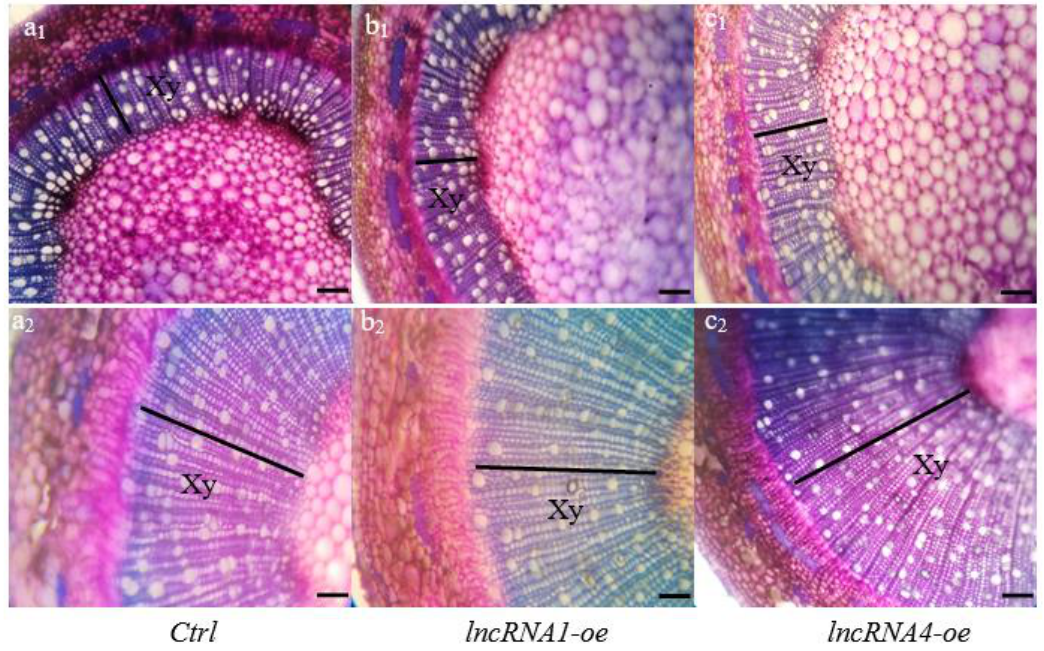
Figure 9. The slice of overexpression and wild type 84K poplar trees. ( a1 ) represented the central stem, ( a2 ) was the basal part of ten-week-old wild type 84K. ( b1 ) represented the central stem, ( b2 ) was the basal part of ten-week-old lncRNA1-oe. ( c1 ) represented central stem, ( c2 ) was the basal part of ten-week-old lncRNA4-oe. Xy represented xylem. Scale bar was 200 µm.